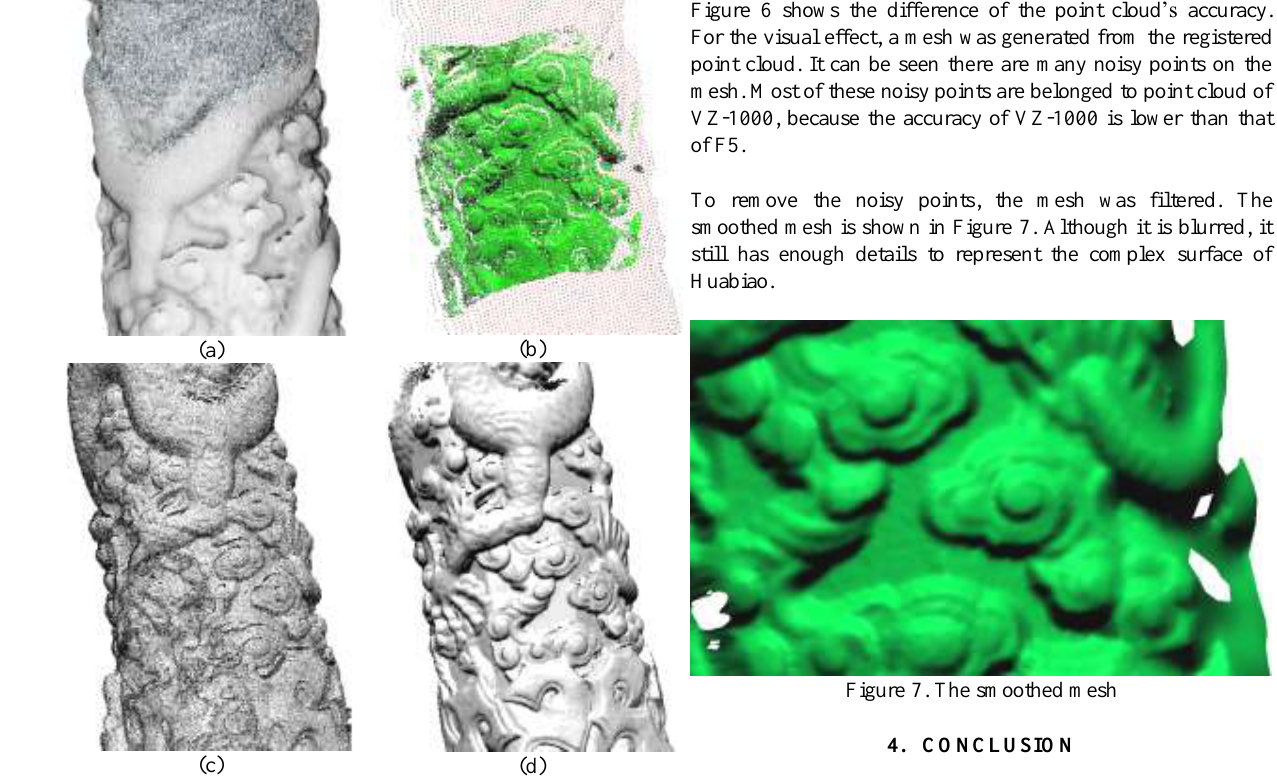
Figure 5. The difference of point cloud’s density. (a) shows a portion of registered point cloud; (b) shows the point cloud from VZ-1000 (red) and F5 (green); (c) is a portion of VZ- 1000 point cloud; (d) is a portion of F5 point cloud.